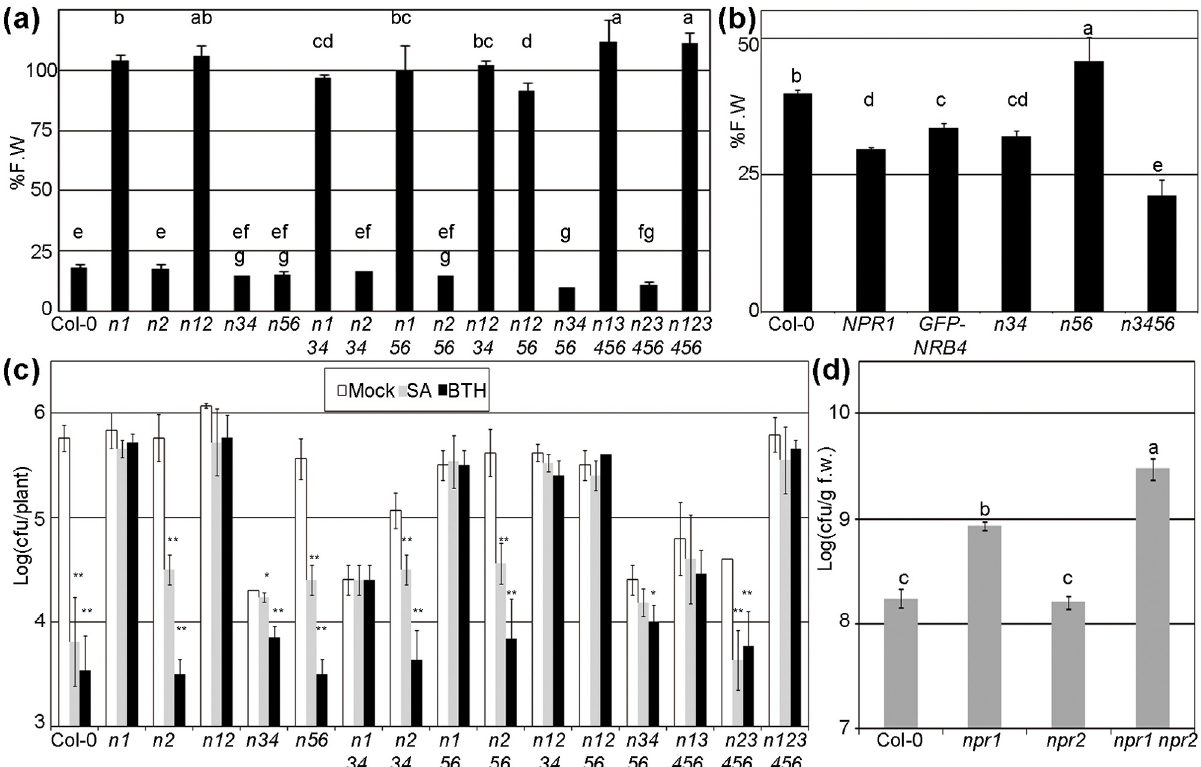
Fig 2. Phenotypes of the NPR1 paralogs knockouts. (a) SA perception of combinations of KOs, measured by fresh weight after BTH treatment, as in Fig 1a. The abbreviations used are: n1 = npr1-1; n2 = npr2; n3 = npr3; n4 = npr4; n5 = bop2; n6 = bop1 . The combinations of mutants are indicated by the letter “n” and the corresponding numbers, e.g. n1234 correspond to the quadruple npr1-1 npr2 npr3 npr4 . (b) Enhanced SA perception of the quadruple npr3 npr4 bop1 bop2 . Plants were treated and measured as in (a), but with a ten-fold reduction in the BTH, to visualize increased sensitivity to SA. 35S : NPR1 and 35S : GFP-NRB4 are included as controls of enhanced perception ([31] and [4] respectively). (c) SA perception, measured as pathogen growth as in Fig 1b. (d) eds-like phenotype. Seven-week-old plants were hand infiltrated with Pto at 5 � 10 4 cfu/mL. Three days after inoculation, the growth of Pto was evaluated as the Logarithm of cfus per g of fresh